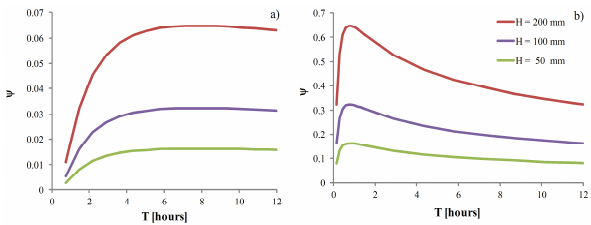
Fig. 2. Pressure head at the bottom of the soil layer versus rain- Figure 2. Pressure head at the bottom of the soil layer versus rainfall duration at constant 3 fall duration at constant cumulative rainfalls ( H) . Input data of the cumulative rainfalls ( H ). Input data of the simulations are reported in Table 1. a) D 0 = 6 · 10 -5 4 simulations are reported in Table 1. (a) D 0 = 6 × 10 − 5 m 2 s − 1 , m 2 /s, b) D 0 = 6 · 10 -4 m 2 /s 5 (b) D 0 = 6 × 10 − 4 m 2 s − 1 .